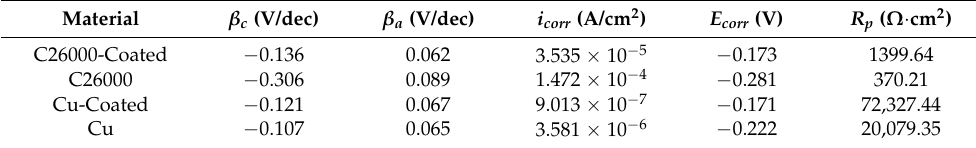
Table 2. Tafel constant, corrosion current, and corrosion